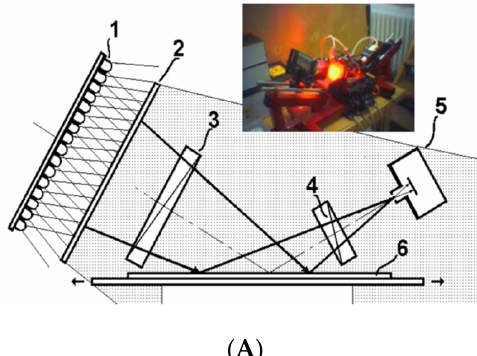
Figure 3. ( A ) Schematic of non-collimated ellipsometry and ( B ) measurement result of a 3D thickness profile originated from Ref. [36]; 1, extended source; 2, diffusor screen; 3, polarizer; 4, analyzer; 5 pinhole and CCD camera; 6, sample with a moving stage.